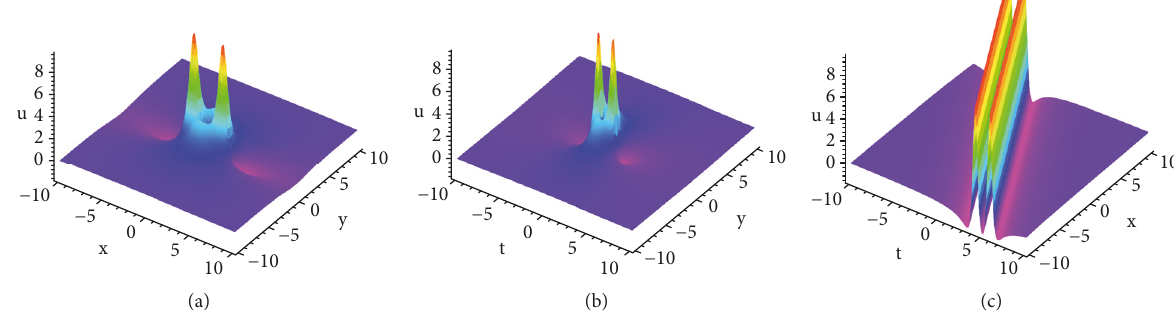
Figure 2: Plots (colored online) of rogue wave 𝑢 2 with 𝑚 = 2,𝑎 = 𝑏 = −2 . (a) Perspective view of the wave 𝑢(𝑥, 𝑦, 0) , (b) perspective view of the wave 𝑢(0, 𝑦, 𝑡) , and (c) perspective view of the wave 𝑢(𝑥, 0,𝑡)